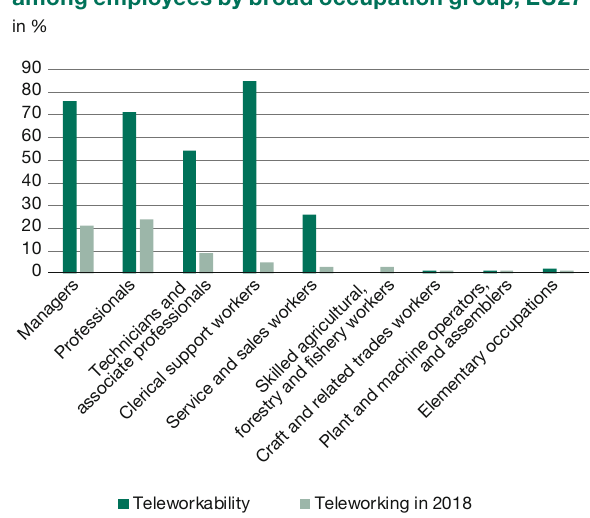
Figure 7 Teleworkability and actual teleworking in 2018 among employees by broad occupation group, EU27 in